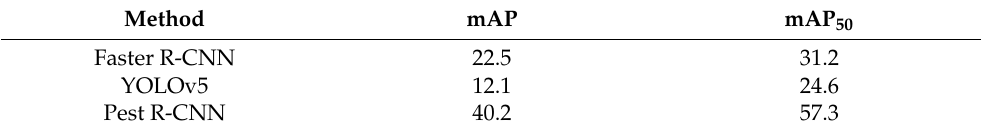
Table 3. Comparison of the object detection accuracy for different object detection methods.